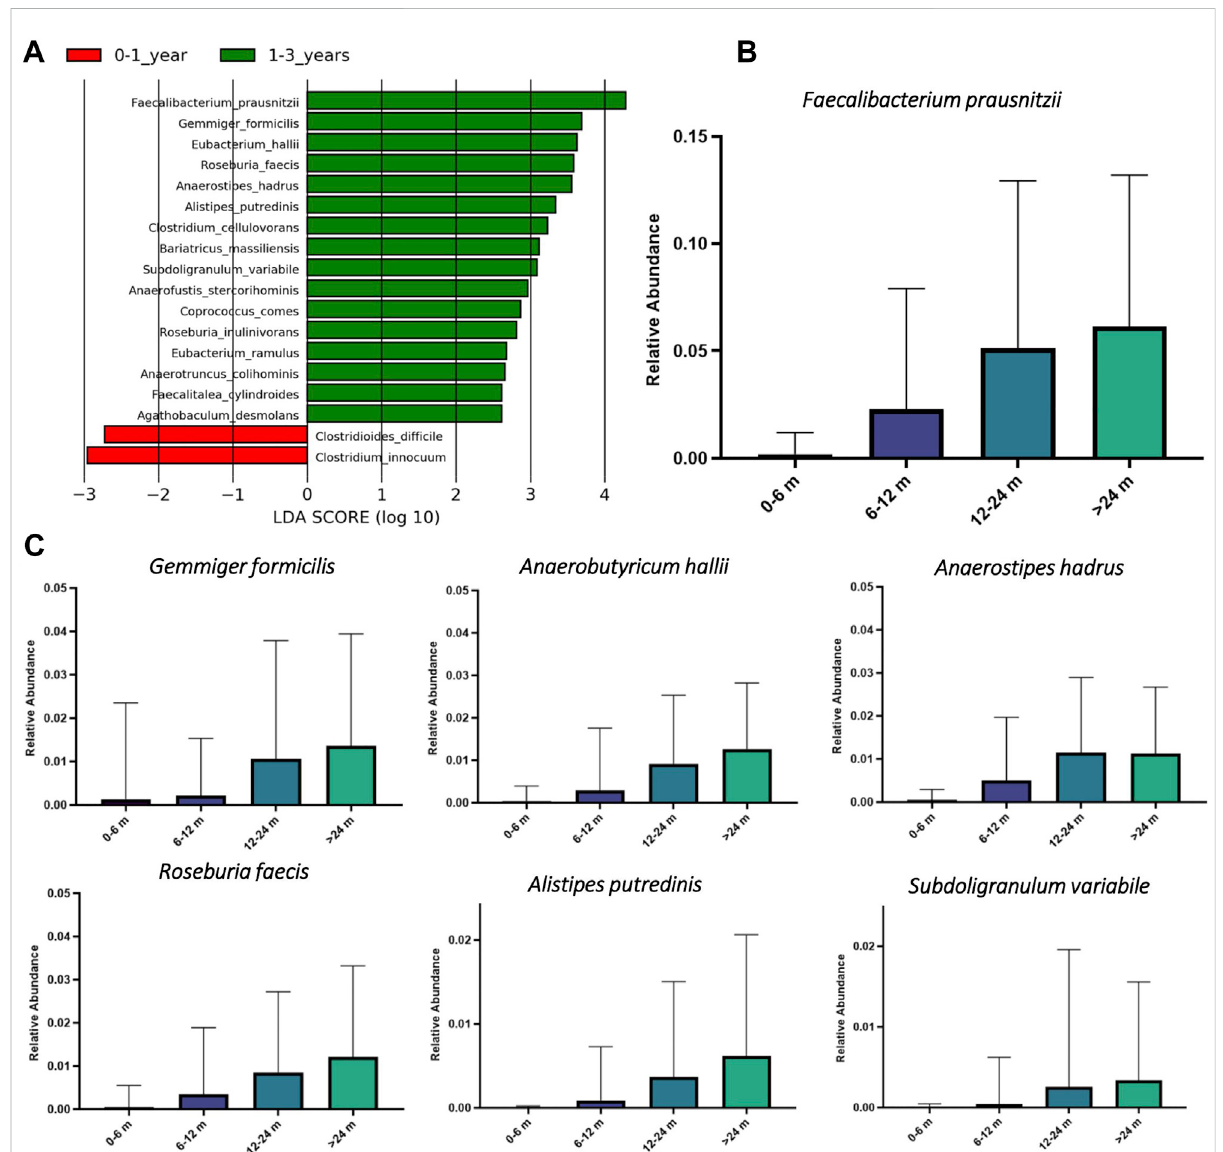
FIGURE 5 Li near discriminant analysis with effect size (LEfSe) for butyrate producers in HGM samples from young children of different age groups in the TEDDY study. (A) The LEfSe analysis was performed on taxonomic abundances of Amplicon Sequence Variants (ASVs) representing predicted butyrate producers in each sample. LDA score plot includes top taxonomic species corresponding to the most discriminative butyrate producers between two age groups of children. (B) and (C) Boxplots of relative abundances of the most dominant butyrate producing species in HGM samples from children in different age